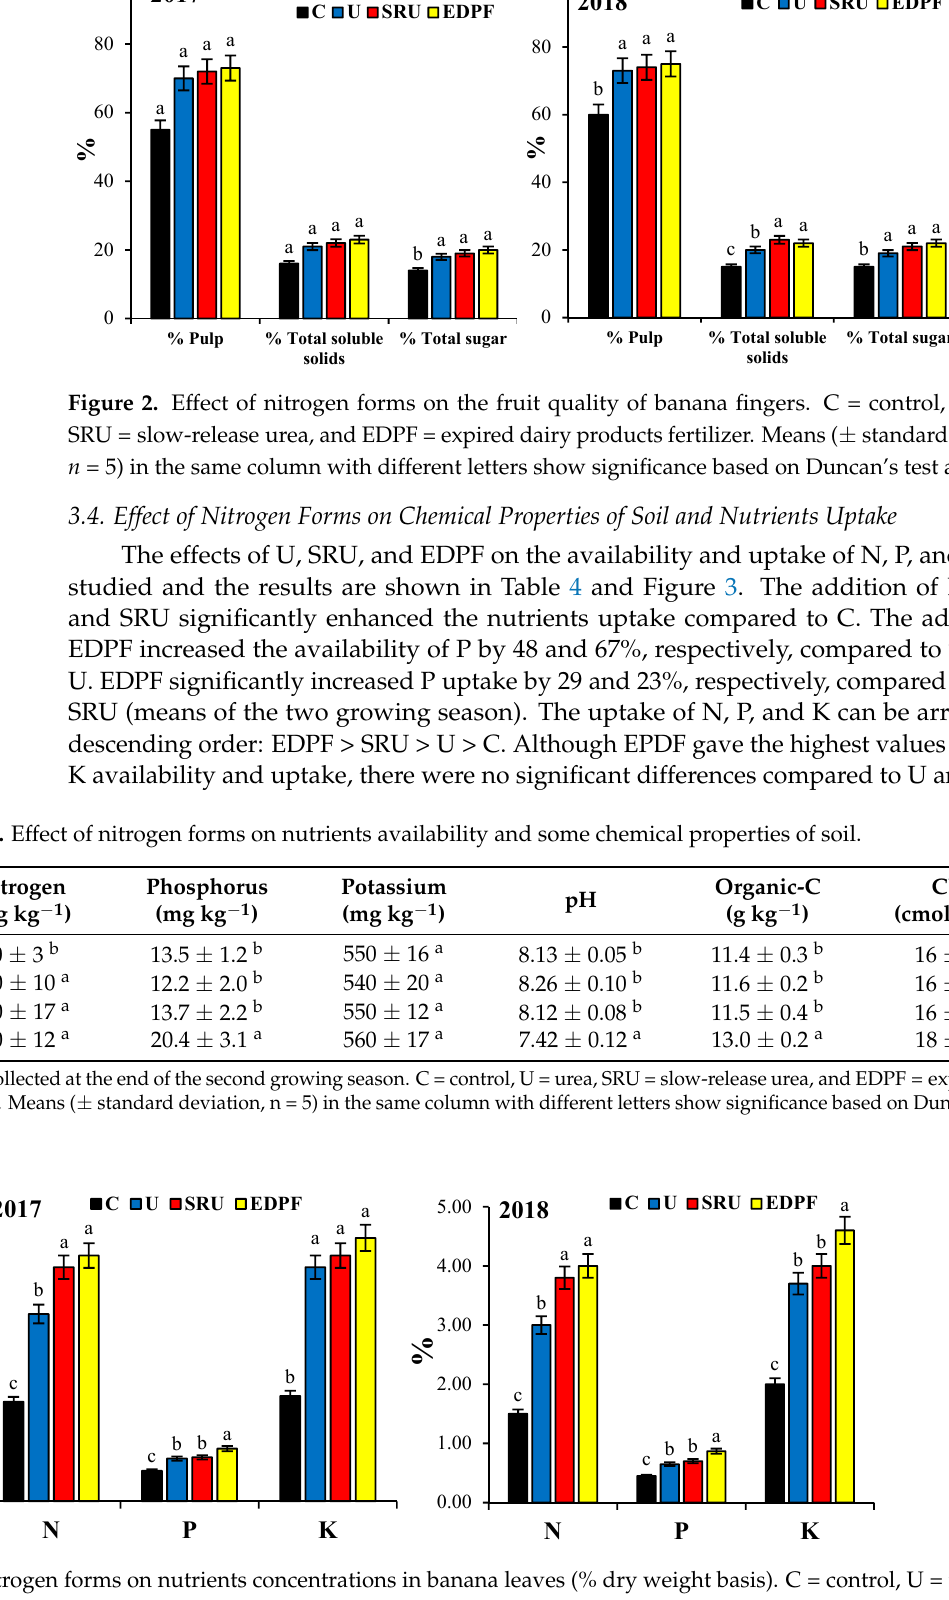
Figure 3. Effect of nitrogen forms on nutrients concentrations in banana leaves (% dry weight basis). C = control, U = urea, SRU = slow-release urea, and EDPF = expired dairy products fertilizer. Means ( ± standard deviation, n = 5) in the same column with different letters show significance based on Duncan’s test at p <